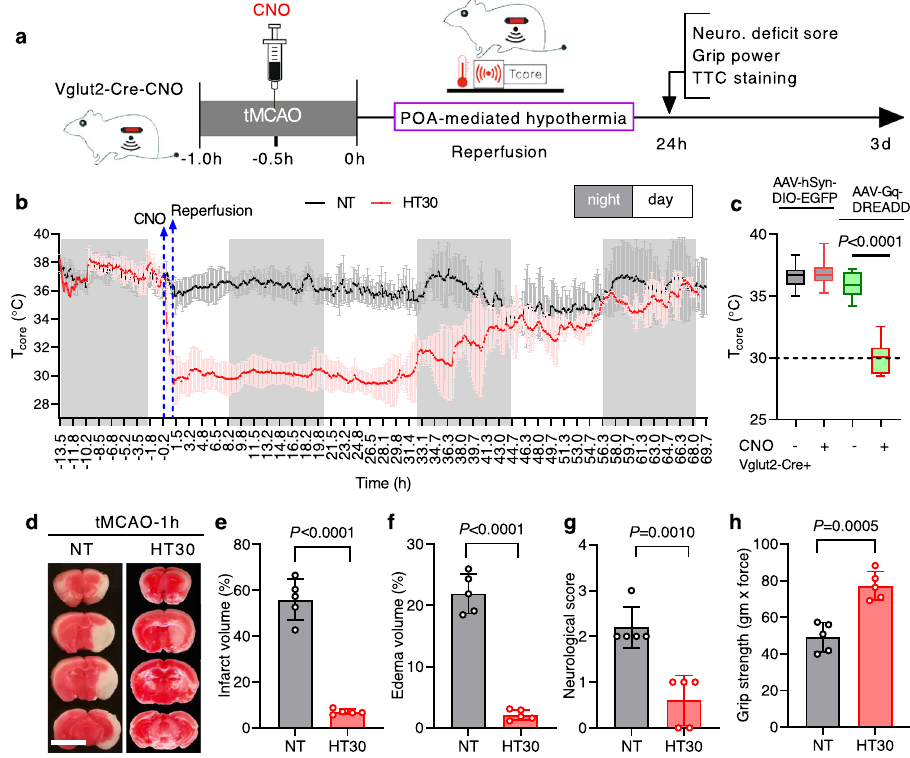
Fig. 1 | Chemogenetic-evoked hypothermia protected the ischaemic brain during reperfusion. a Schematic of experimental design. Vglut2-Cre mice were injected with control-AAV and Gq-DREADD-AAV for 3 weeks, followed by transient middlecerebralarteryocclusion(tMCAO)surgery. b Clozapine-N-oxide(CNO)was injected via i.p. 1h post tMCAO. T core reached 30°C 1h after CNO injection and stayedat30°Cforalmost24hduringreperfusion.Recordingsof